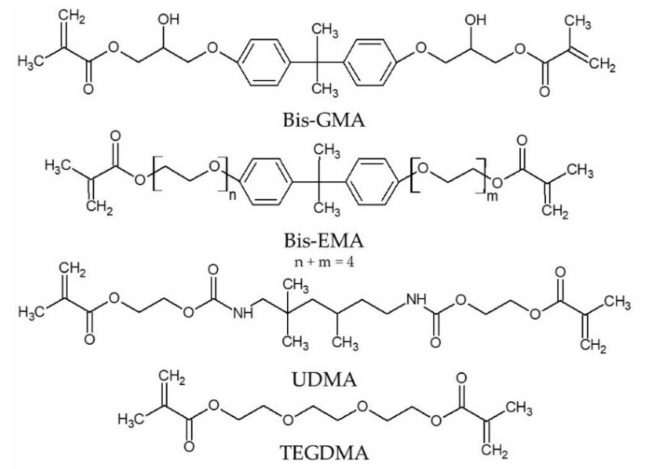
Scheme 1. The chemical structure of typical dental